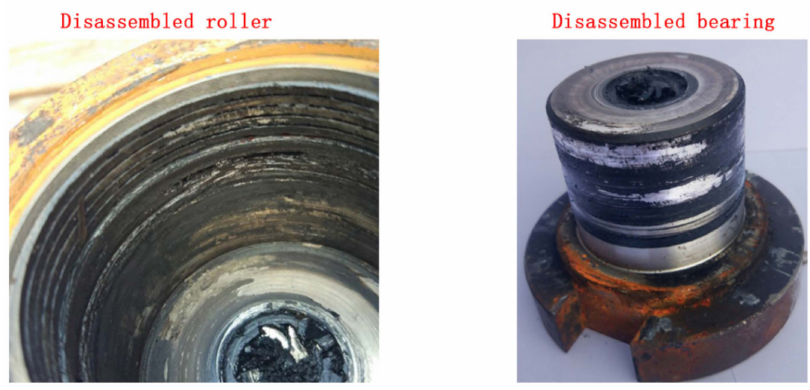
Figure 14. Drilling bit after the